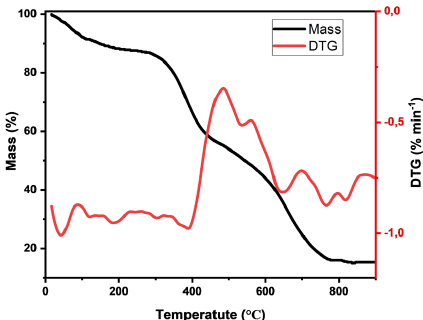
Figure 2. Thermogravimetry and Derivative Thermogravimetry (TG/DTG) of NiMoO synthesized via the complexation method 4 combining EDTA-Citrate.